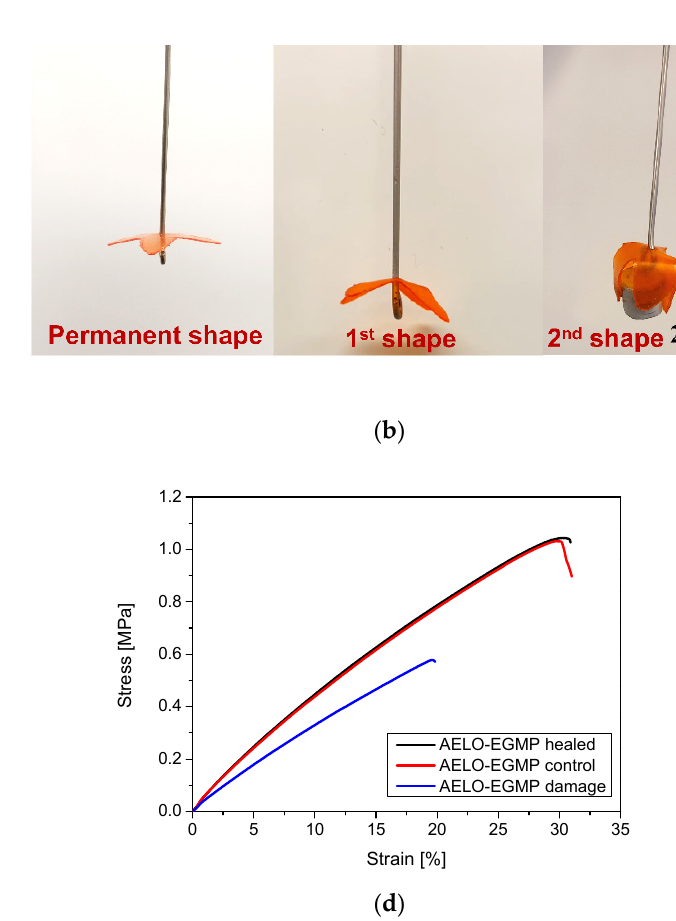
Figure 6. ( a ) Photographs representing the triple shape memory of DLP 3D-printed AELO-EGMP structures. The first shape was programmed above the T v of AELO-EGMP while the second shape of material was programmed using the T g of the photopolymer. Heating of the programmed object sequentially recovered the permanent shape of the 3D-printed flower; ( b ) DLP 3D-printed structure representing the potential application as gripper by employing shape memory properties; ( c ) DLP 3D-printed control sample, damaged sample with a circular cavity, the disc, and the healed sample for analysis of thermal welding and healing properties; ( d ) Stress–strain curves of control, damaged, and healed samples. Thermal healing was performed at 180 °C for 4 h.